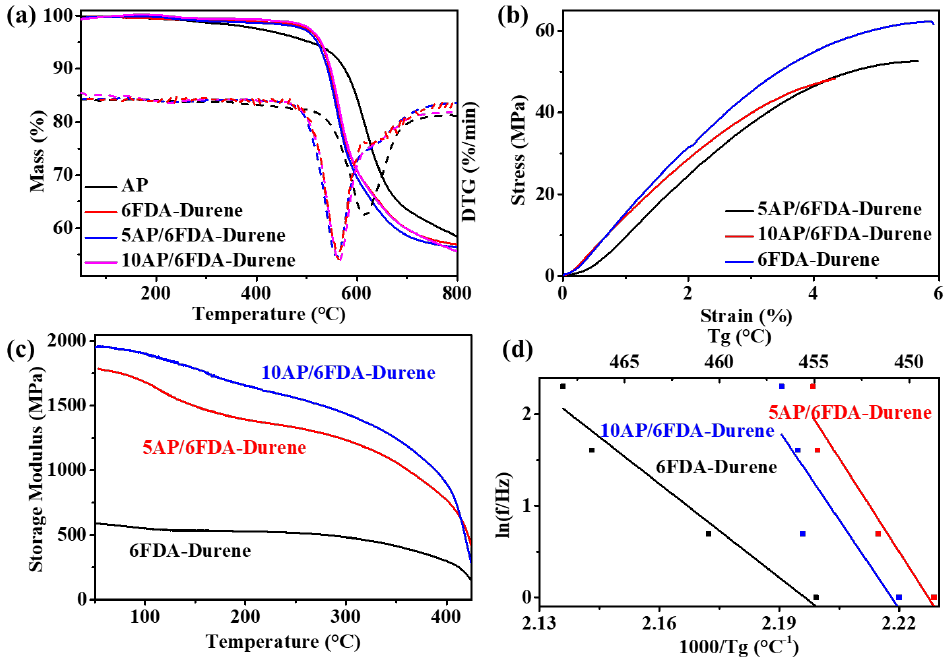
Figure 4. ( a ) TGA (solid line) and DTG (dotted line) of AP and the MMMs with AP loading; ( b ) stress–strain of MMMs with AP loading; ( c ) storage Modulus of MMMs with AP loading; and ( d ) Arrhenius plots of MMMs with AP